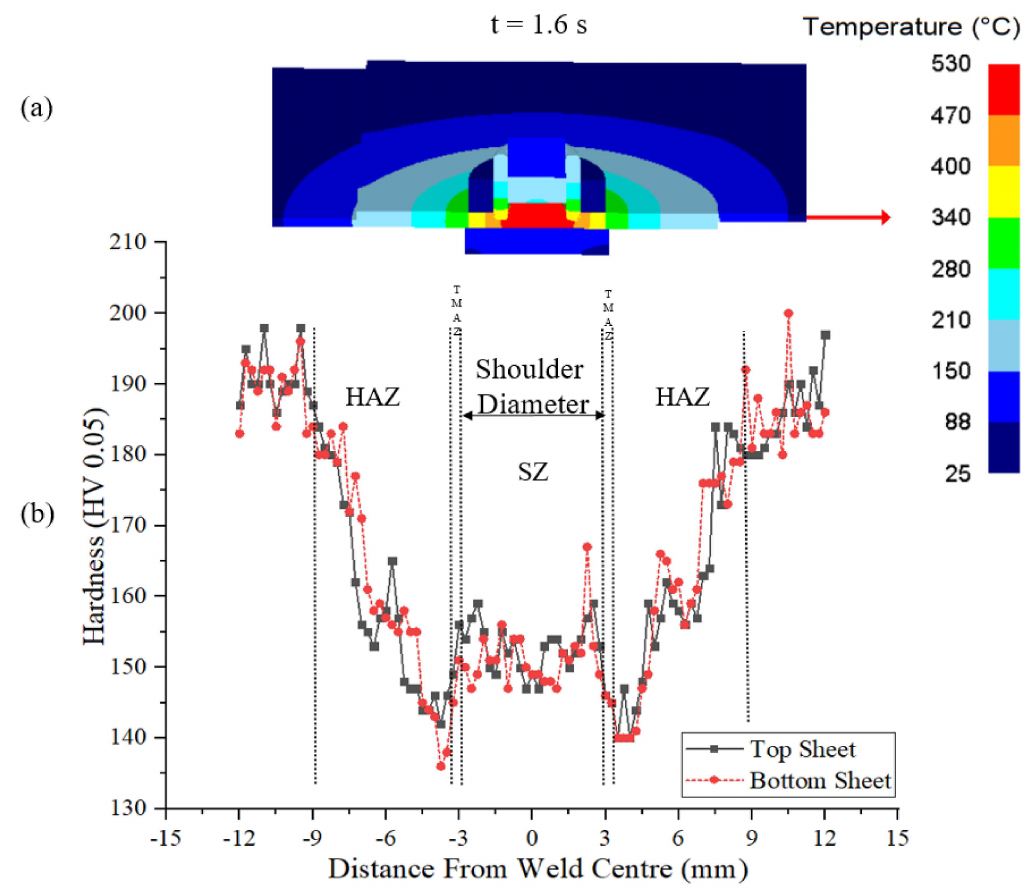
Figure 17. Hardness profile of the top and bottom sheets of the weld ( b ) after welding compared to temperature distribution at t = 1.6 s ( a